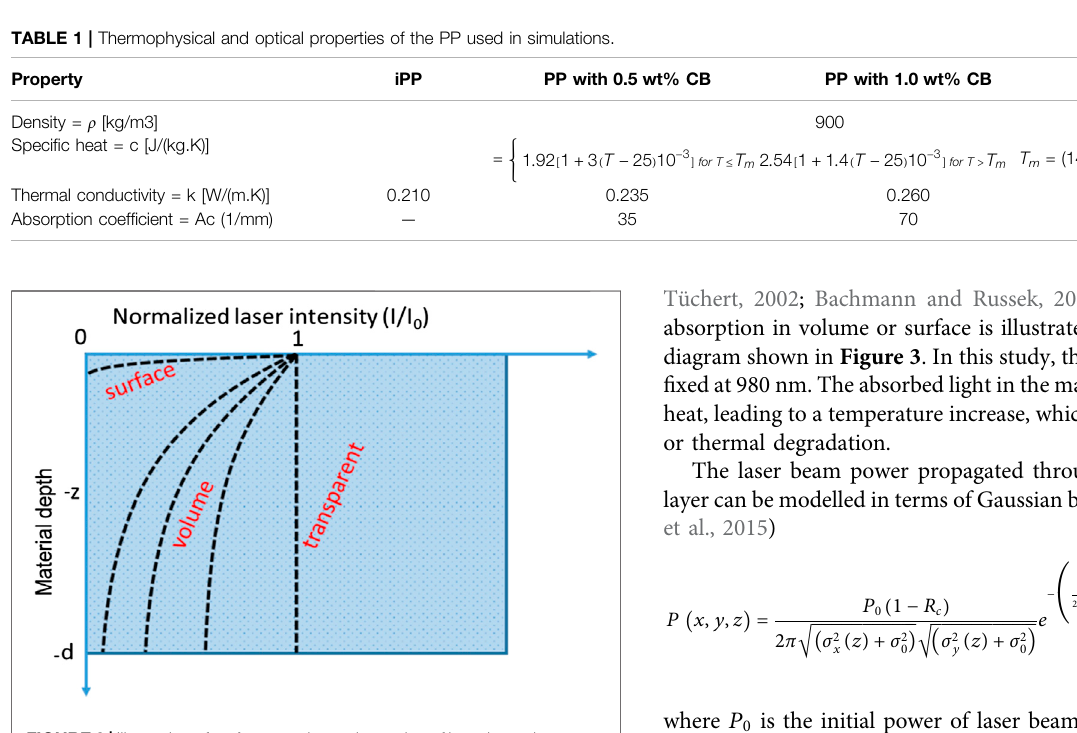
FIGURE 3 | Illustration of surface or volume absorption of laser beam by